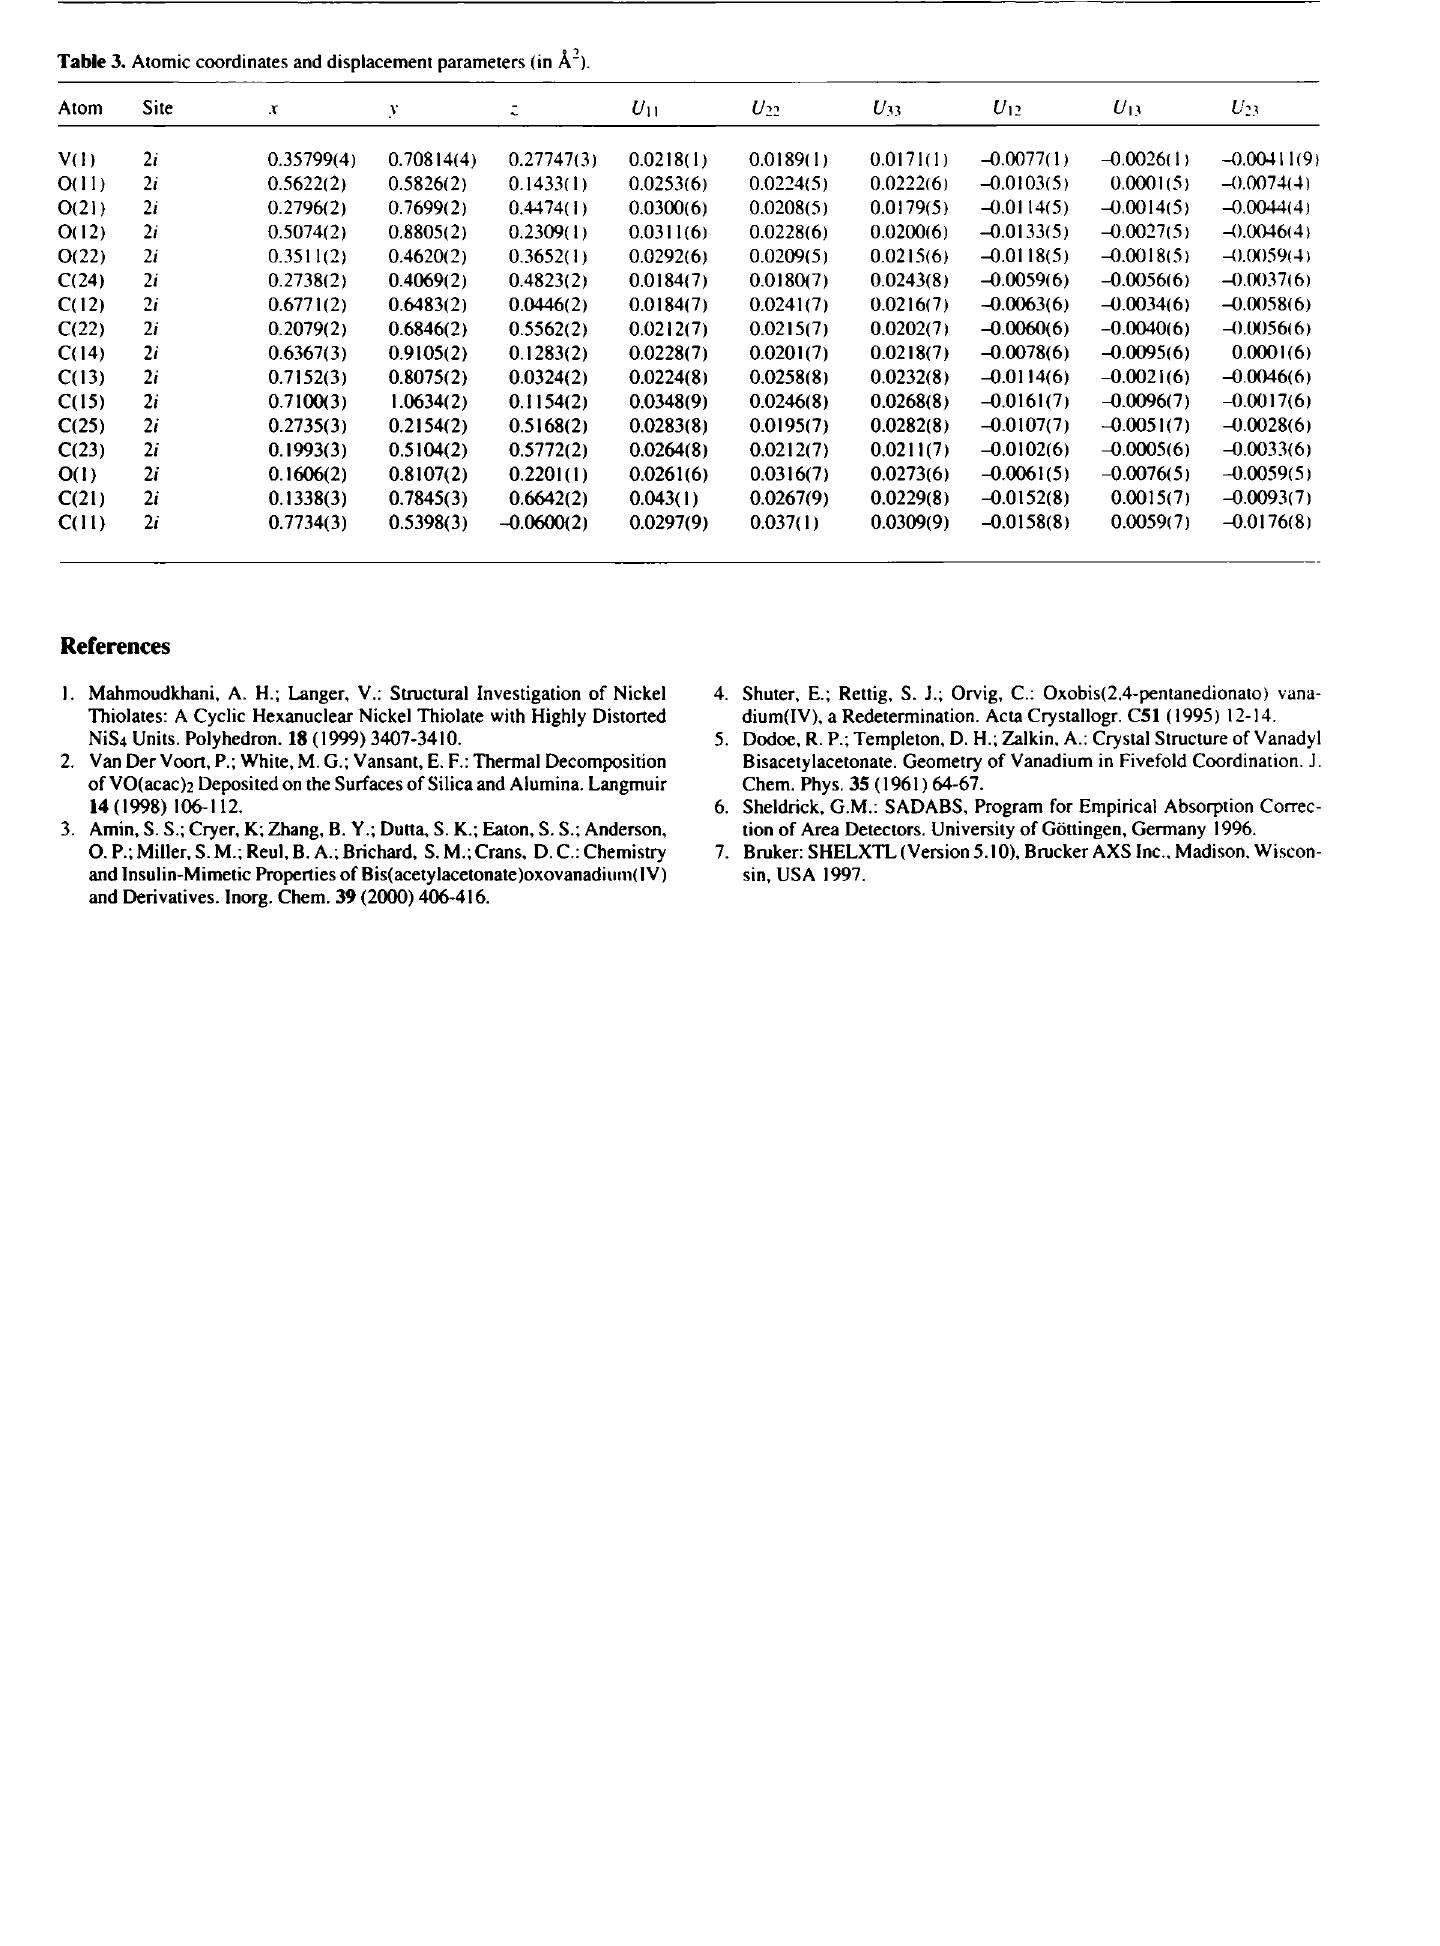
Table 3. Atomic coordinates and displacement parameters (in